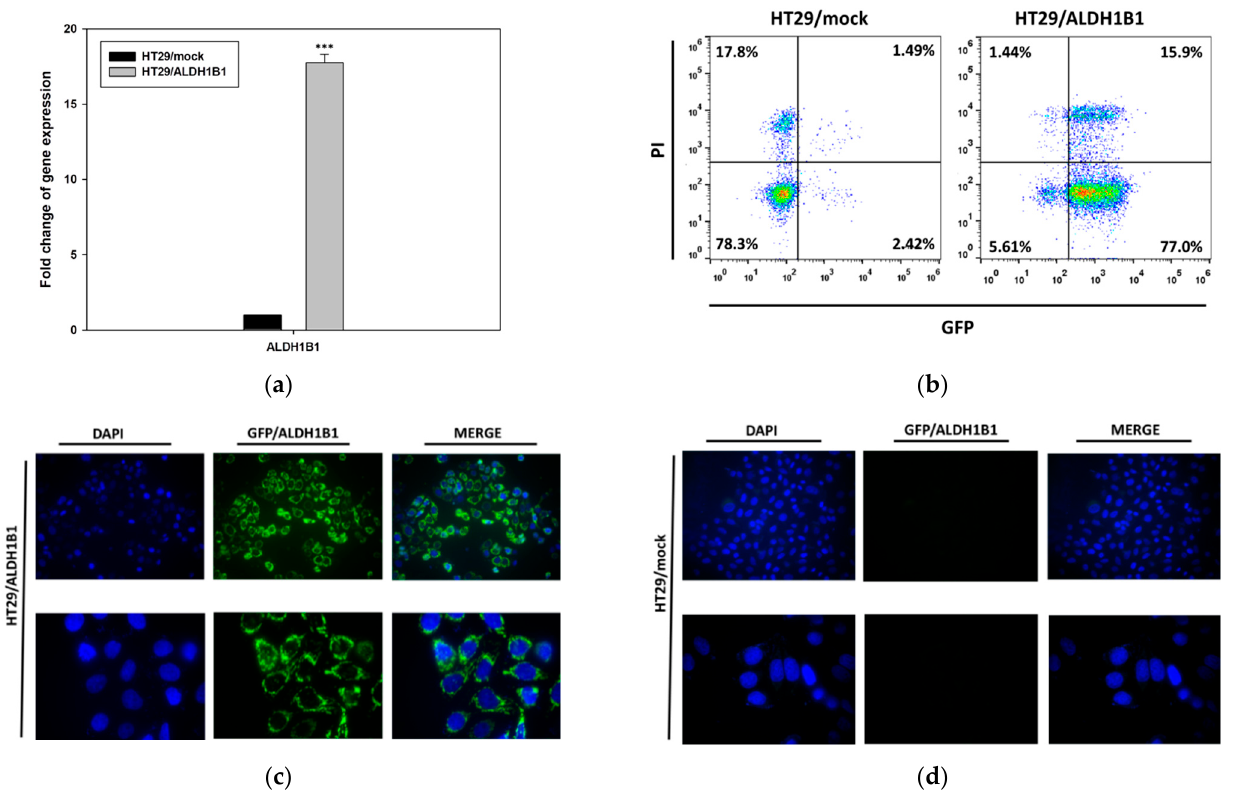
Figure 1. Expression of ALDH1B1 in the HT29 isogenic cell line pair. ( a ) ALDH1B1 gene expression levels detected by real-time PCR in HT29/mock and HT29/ALDH1B1 cells. ( b ) Evaluation of GFP+ cells (green) in HT29/mock and HT29/ALDH1B1 by flow cytometry analysis. Nuclei were stained with propidium iodide (PI) (red). Fluorescence microscopy for detecting the GFP+ cells (green) in HT29/mock ( c ) and HT29/ALDH1B1 ( d ) cells (upper panel at 40 × magnification and lower panel at 100 × magnification). Nuclei were stained with DAPI (4 (cid:48) ,6-diamino-2-phenylindole) (blue). Results are expressed as mean ± SD of three independent experiments. *** p <